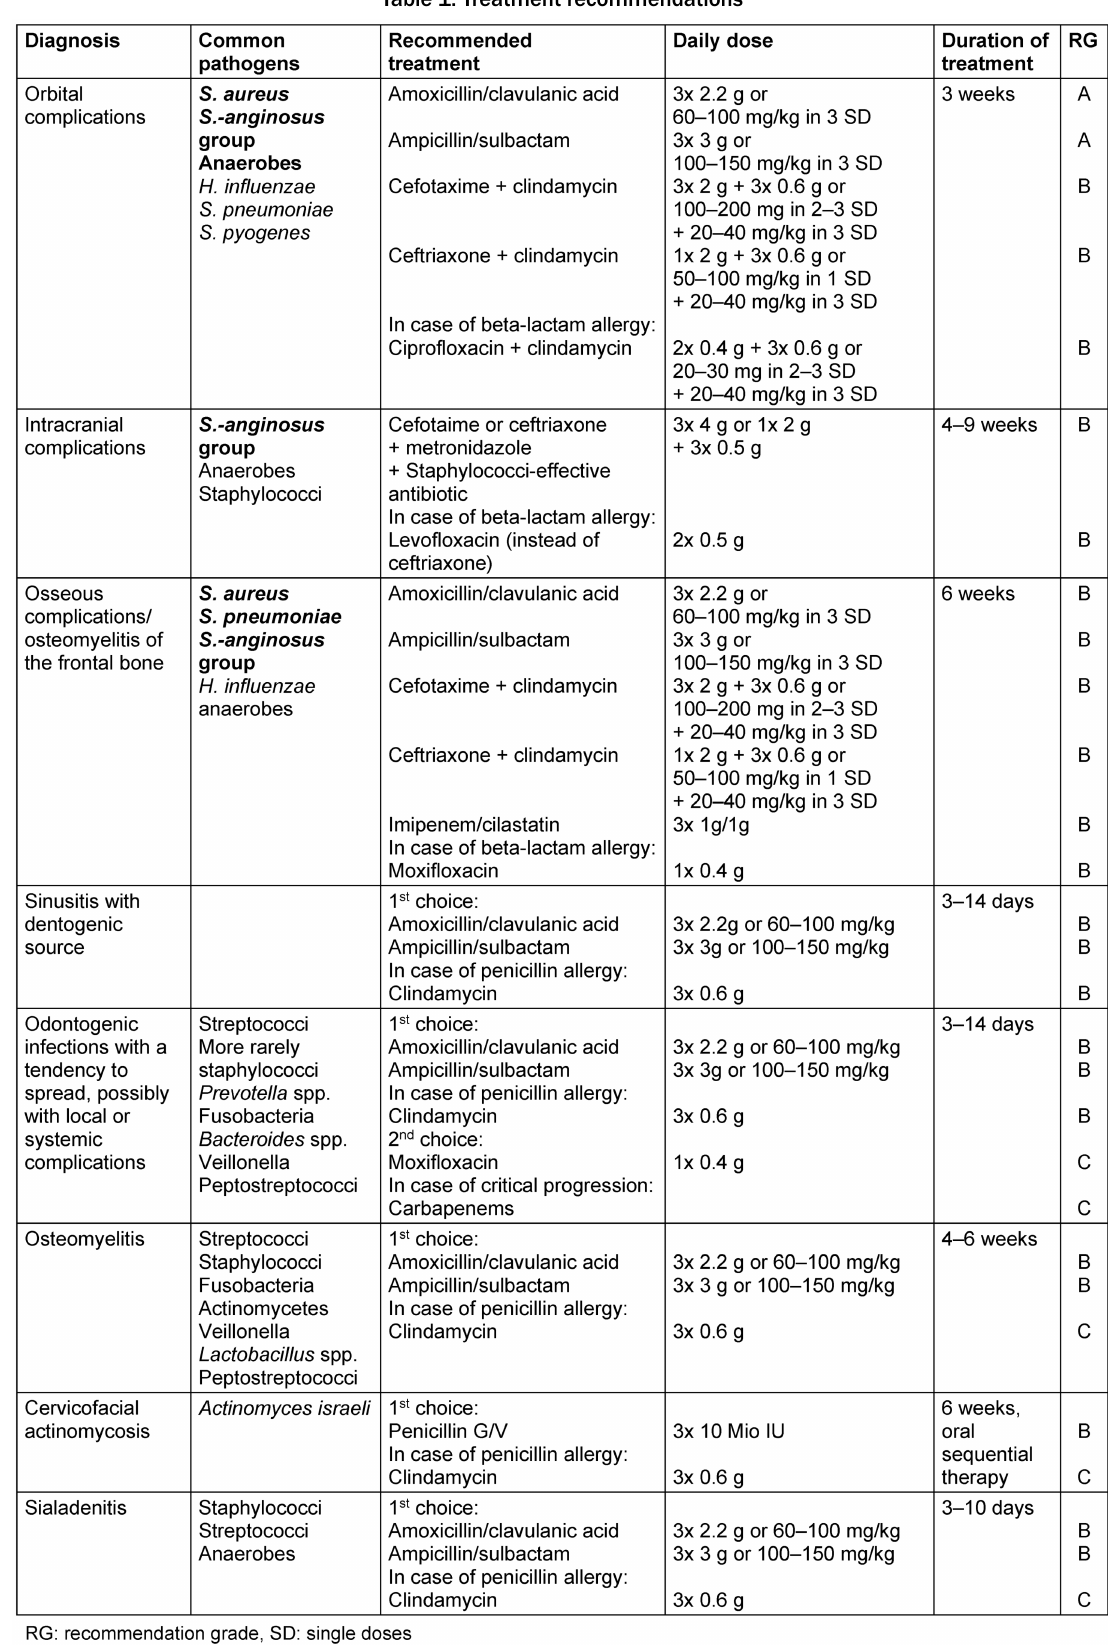
Table 1: Treatment